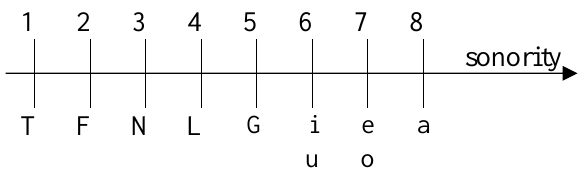
Figure 1 . Sonority